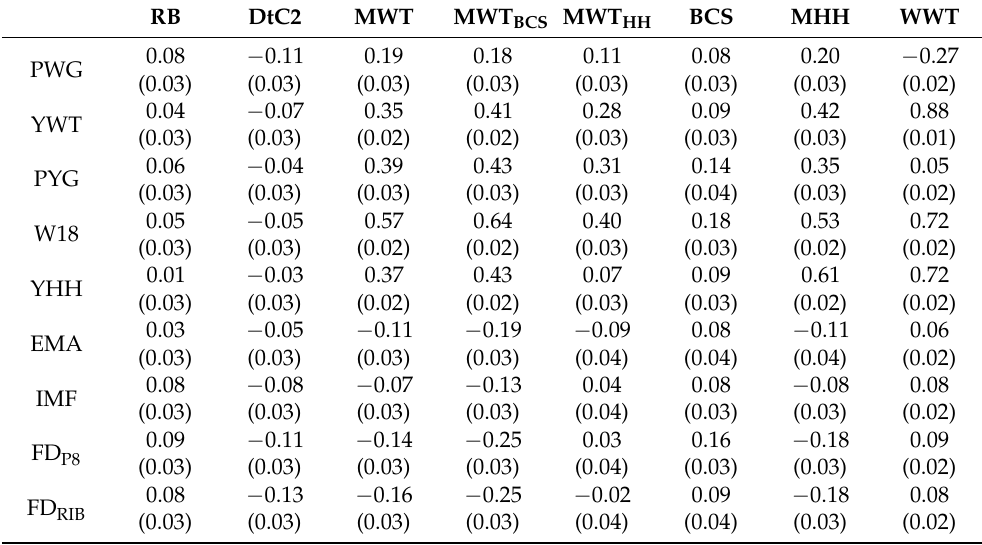
Table 7. Phenotypic correlations (SE) among maternal and finishing traits in New Zealand beef